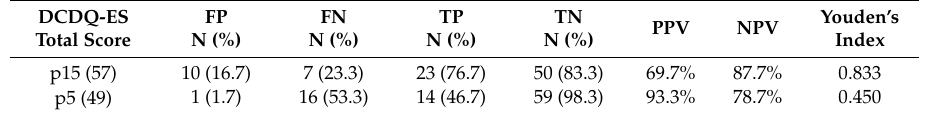
NPV = negative predictive value.